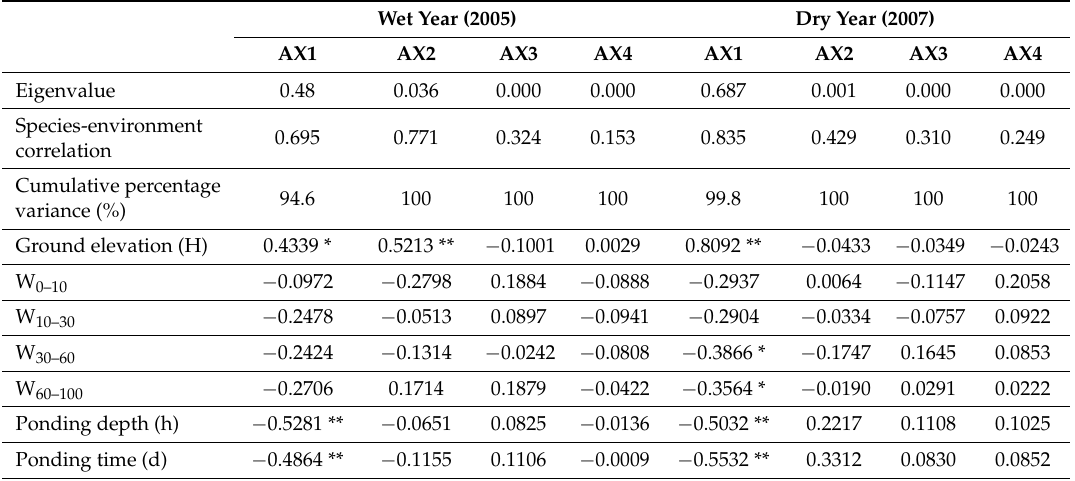
Table 3. Intra-set correlations of the environmental variables, eigenvalue, and cumulative percentage variance and species-environment correlation coefficients for the first four axes of